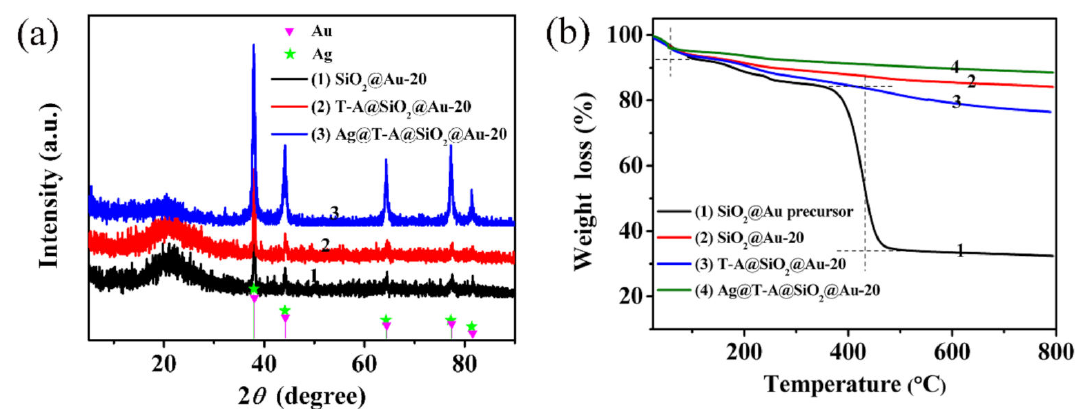
Figure 4. XRD patterns ( a ) of SiO 2 @Au-20, T-A@SiO 2 @Au-20 and Ag@T-A@SiO 2 @Au-20 nanofibers; TGA curves ( b ) of SiO 2 @Au-20 precursor, SiO 2 @Au-20, T-A@SiO 2 @Au-20 and